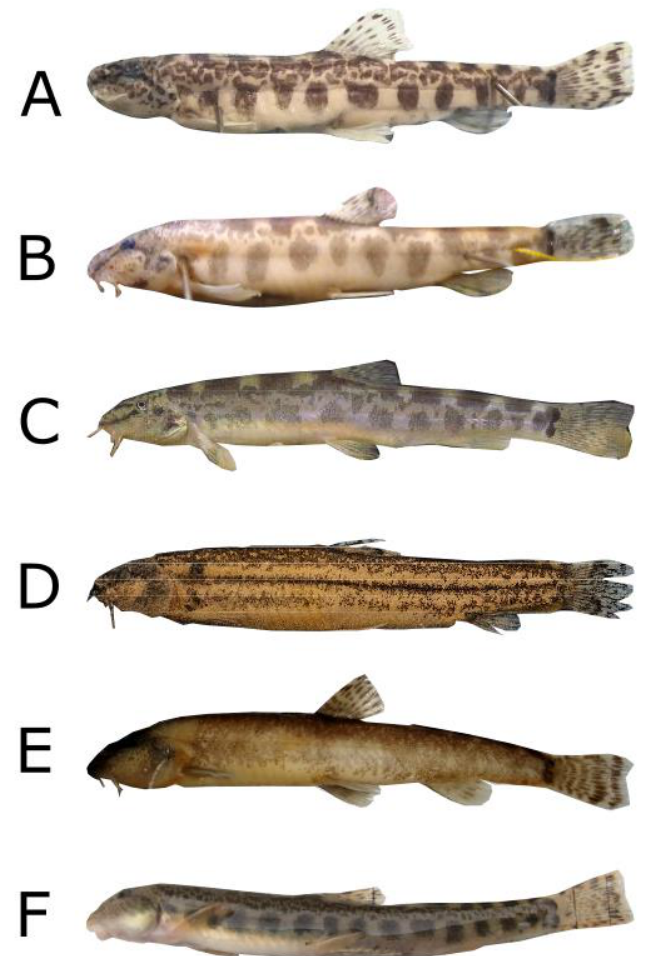
Figure 6. Colouration patterns of the Sabanejewia spp. originating from different types of habitat and elevation. ( A ) S. balcanica , type locality River Treska in Skopje (269 m a.s.l.); ( B ) S. bulgarica , type locality River Danube in Vidin (34 m a.s.l.); ( C ) surface metallic sheen of S. bulgarica originating in the Danube delta of Ukraine (Figure A. M. Naseka in [6]); ( D ) S. caspia – Anzali wetland (28 m a.s.l.) ( in [40]); ( E ) S. baltica – River Ubort near Maidan-Kopishchenskii (154 m a.s.l., river near wetlands) (Figure in [43]); and ( F ) S. baltica – River Stradomka near Chrostowa (215 m a.s.l.) (Figure Michal Nowak).